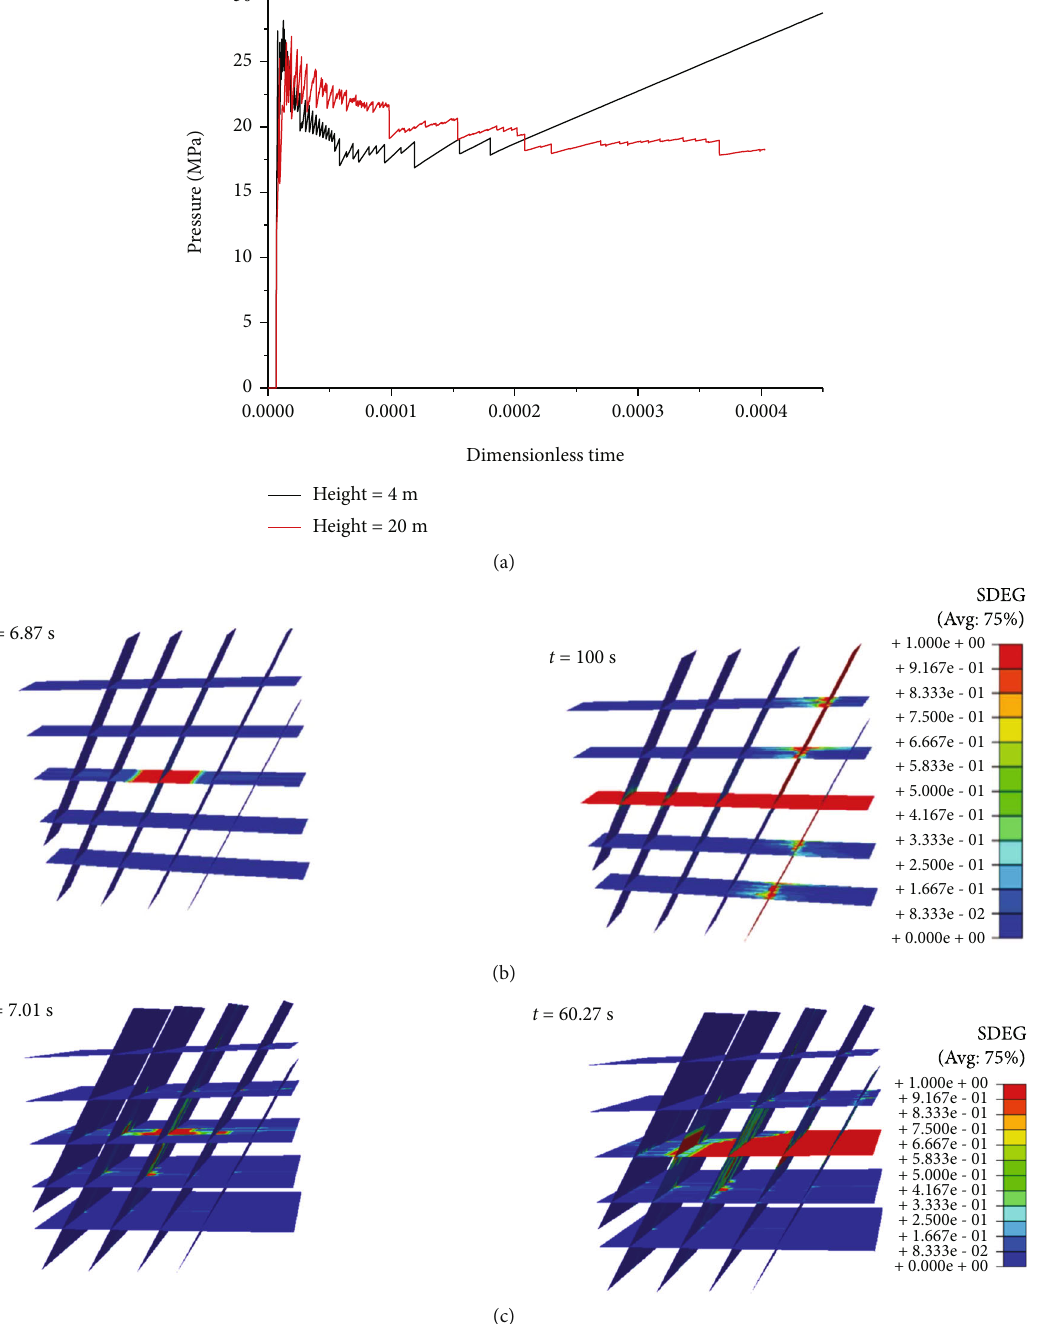
Figure 17: The numerical results at a 60-degree approaching angle with 4 m/20m formation thickness: (a) the fl uid pressure history at the injection point; (b) damage factor with 4m formation thickness (deformation scale factor is 100); and (c) damage factor contours with 20 m formation